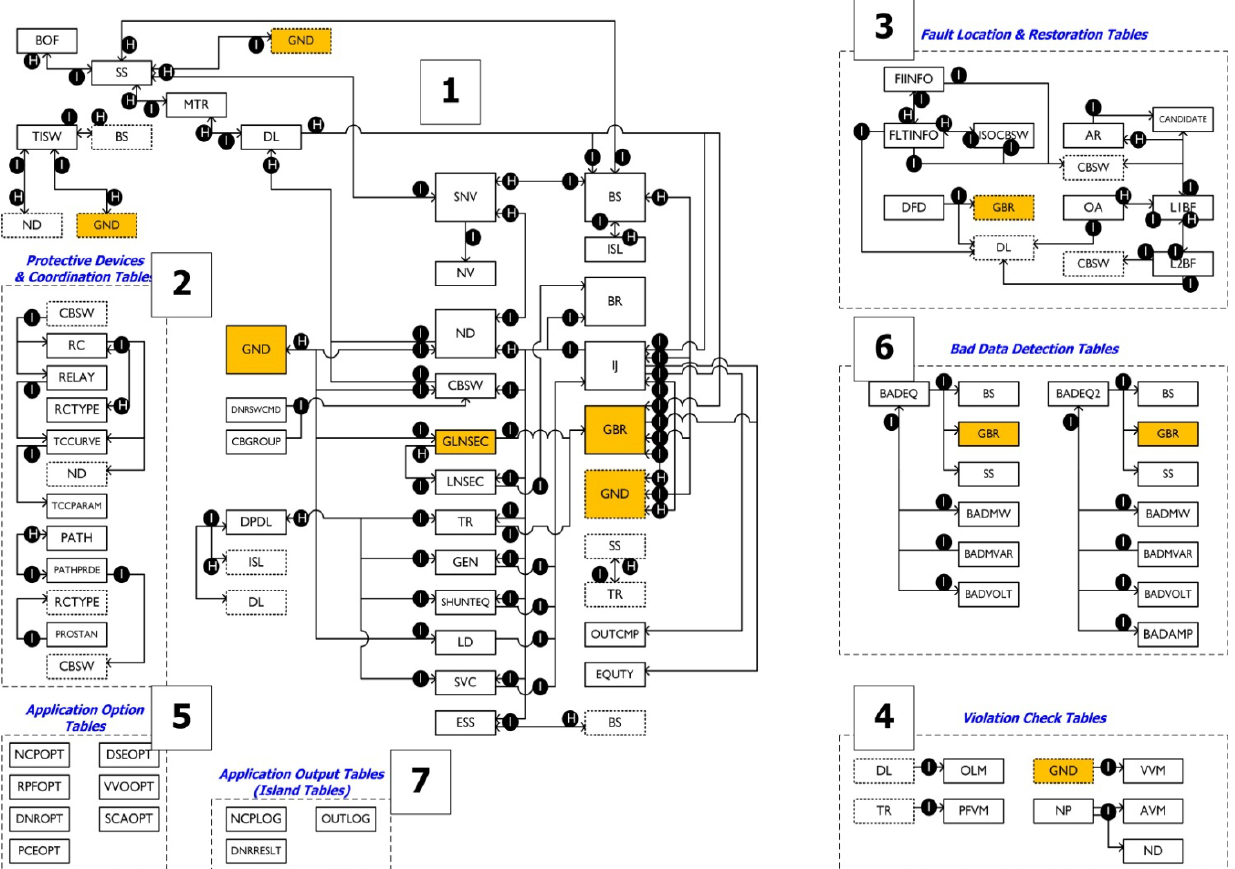
Figure 11. Proposed common database